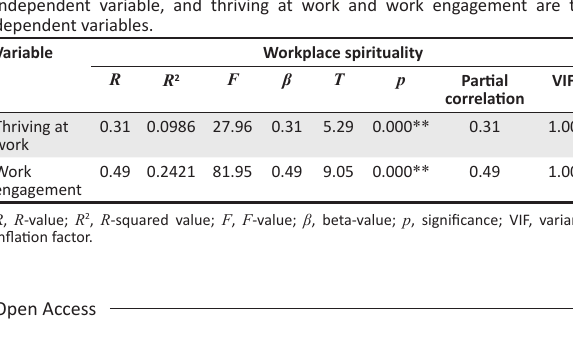
TABLE 2: Measures of central tendency ( n = 259). Construct Sub-construct TABLE 4: Multiple regression analysis results, where workplace spirituality is the